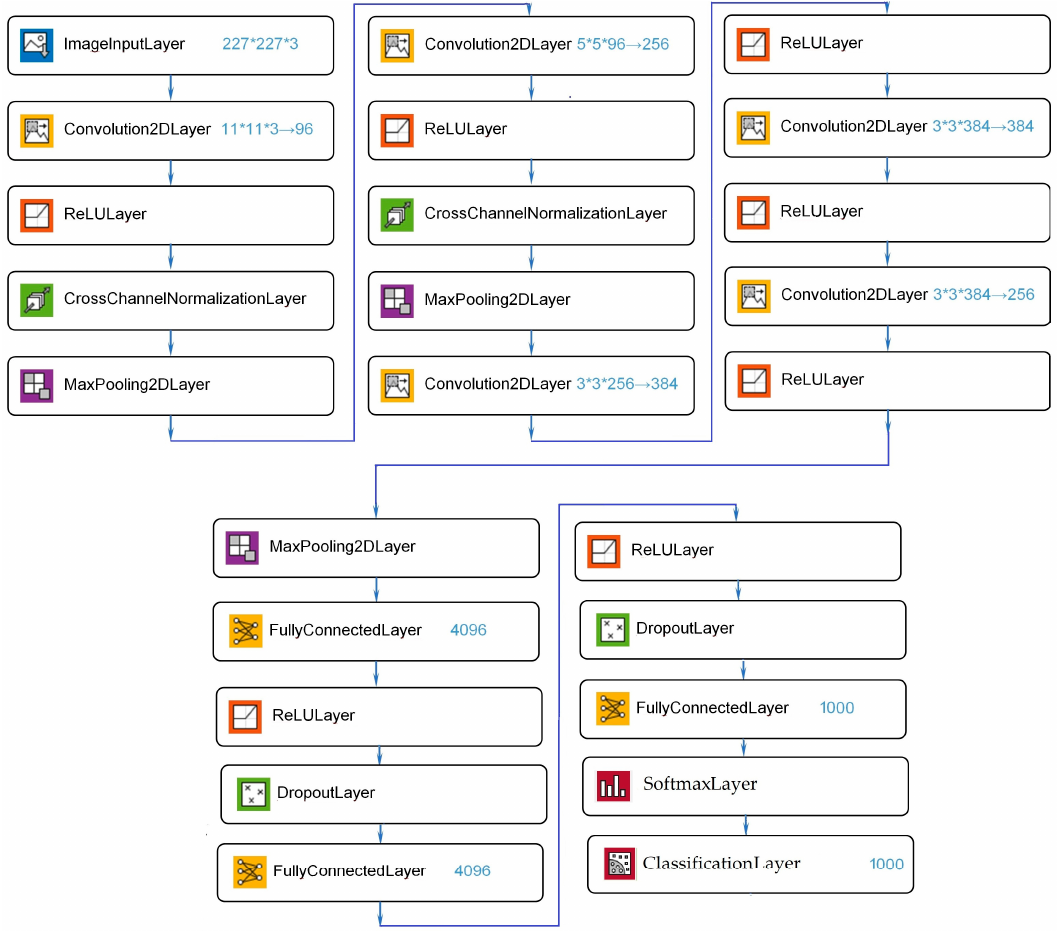
Figure 1. AlexNet in